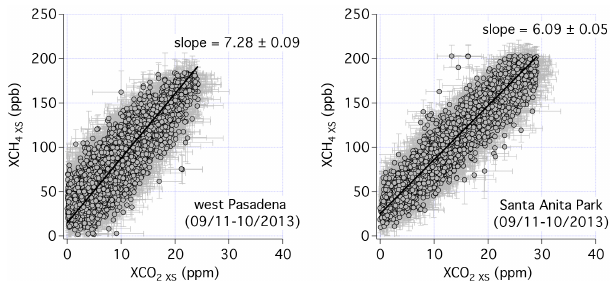
Figure 4. Correlations between XCH 4 ( XS ) (ppb) and XCO 2 ( XS ) (ppm) for west Pasadena and Santa Anita Park during the period of September 2011 and October